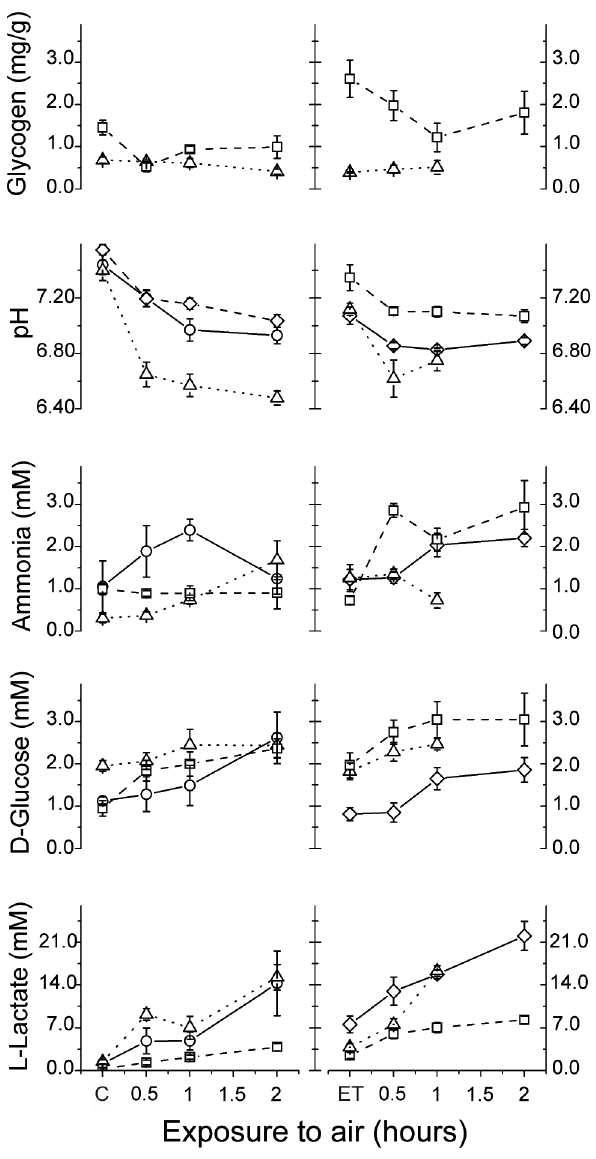
Figure 1. Trends in physiological stress in Squillamantis upon exposure to air. Time dependence of different physiological parameters during the seasonal experiments. Left panels: lab exper- iments; right panels: field experiments. The symbols denote the different seasons: summer (triangles), autumn (squares), winter (circles), and spring (diamonds). C indicates the time zero (controls) in lab experiments; ET stands for end-of- tow in field experiments. shock experienced by the organisms in the two seasons ( + 10.5 u C and 2 1 u C in the summer and autumn experiment, respectively;